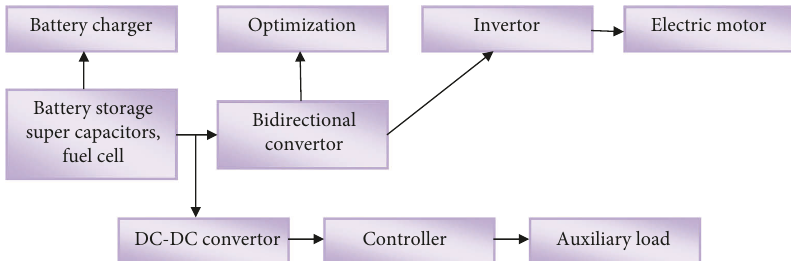
Figure 1: Architecture of interfacing and application of power electronic